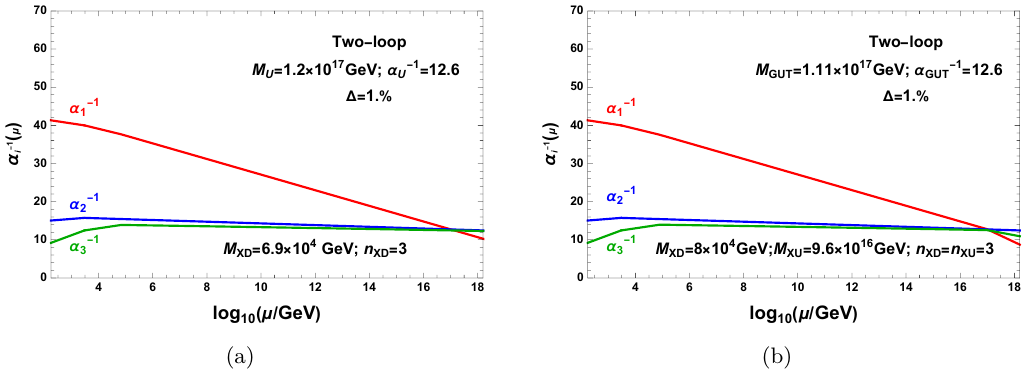
Figure 18 . Two-loop evolution of gauge couplings for the Model 16 with vector-like particles. In this model, k = 10 × 5 and k = 2 . The string-scale gauge coupling relation can be achieved by Y 2 7 3 adding 3( XD + XD ) (a) as well as 3( XU + XU ) (b).